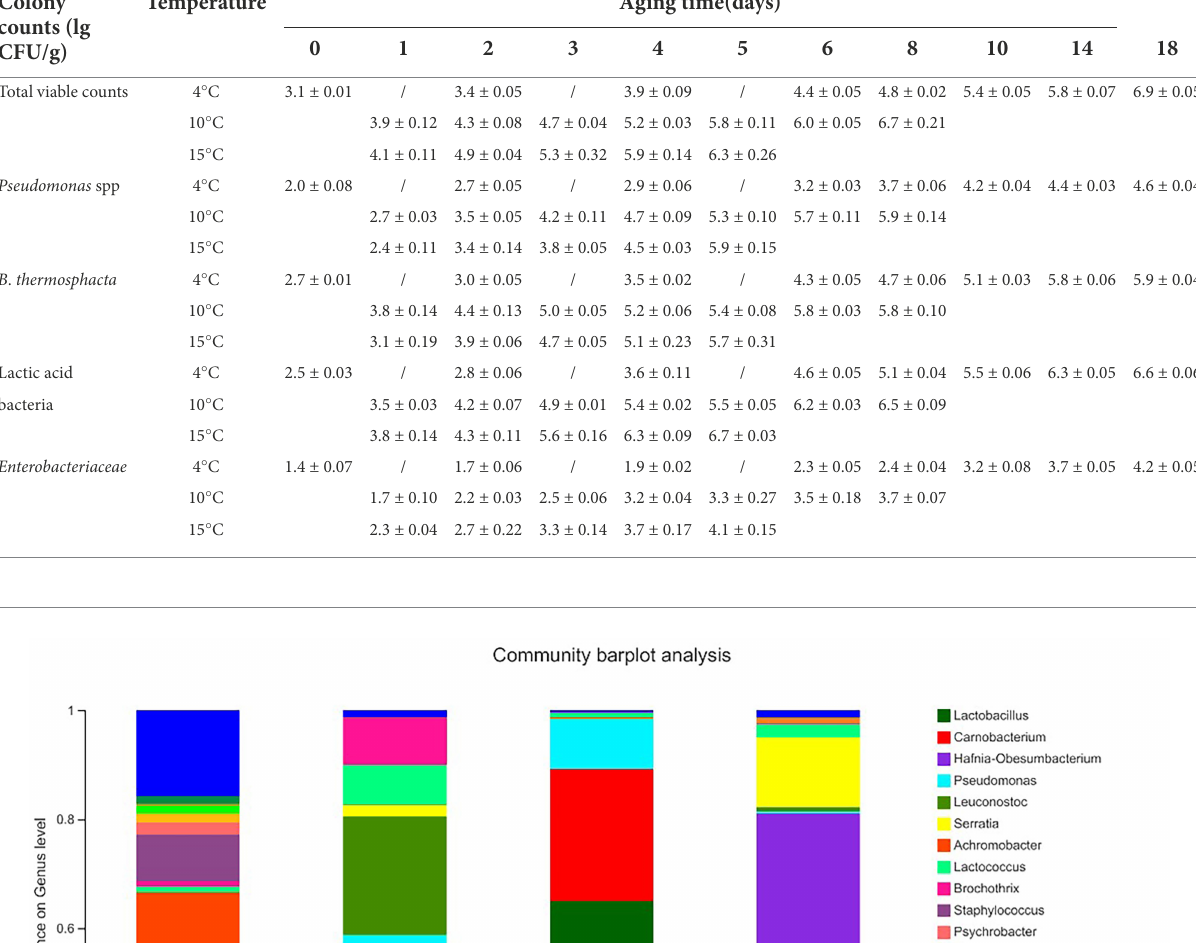
TABLE 1 Microbial counts of beef samples under different aging